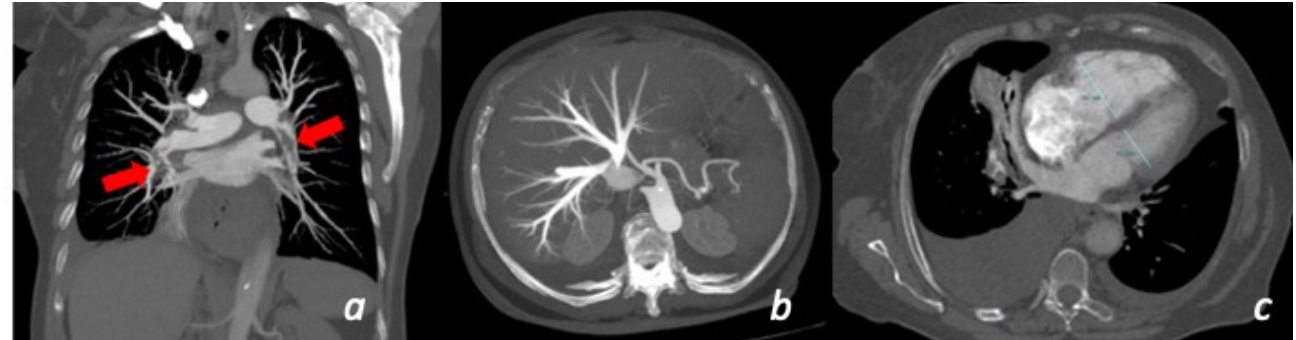
Figure 6. Patient with chest pain and dyspnea for more than 10 days with recent worsening of symptoms. CT shows the presence of massive bilateral pulmonary thrombo-embolism (red arrows) in the right and left lower lobe pulmonary artery ( a ). Secondary overload of the right-side circulation: enlargement of the right ventricle ( c ) and secondary tricuspid insufficiency ( b ).